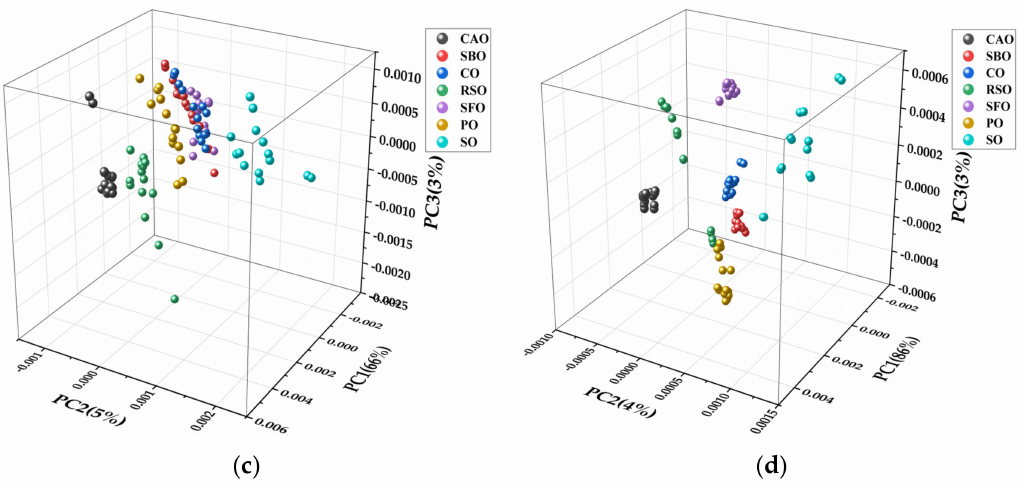
Figure 4. Three-dimensional score plot of pure CAO, SBO, RSO, CO, SFO, PO, and SO from principal component analysis (PCA) analysis of FTIR spectra in the wavenumber region of ( a ) 4000–650 cm − 1 , ( b ) 3050–2750 cm − 1 and 1800–650 cm − 1 , ( c ) 3050–2750 cm − 1 , ( d ) 1800–650 cm − 1 . CAO, camellia oil; SBO, soybean oil; RSO, rapeseed oil; CO, corn oil; SFO, sunflower oil; PO, peanut oil; SO, sesame oil.